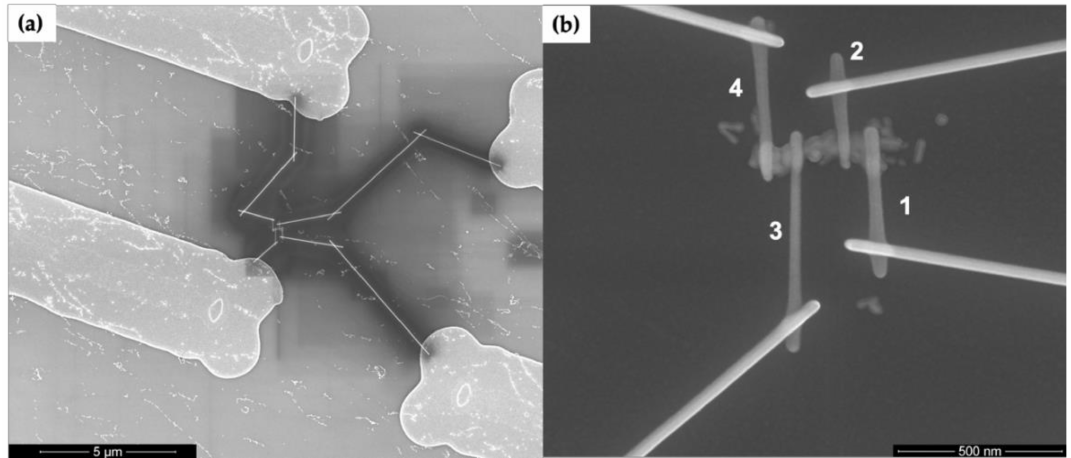
Figure 6. SEM images of electron beam induced deposition (EBID) connections to Au-plated DNA nanotubes seeded with Au nanorods. ( a ) Completed EBID pattern connecting a nanowire to four Au pads. ( b ) Zoom view of the Au plated nanowire in ( a ) with numbered